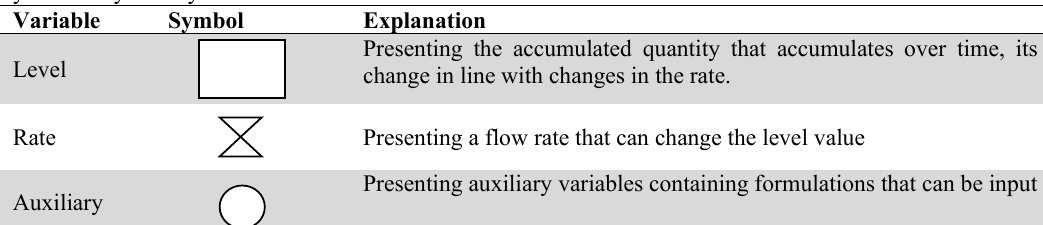
Presenting the accumulated quantity that accumulates over time, its value can change in line with changes in the rate.